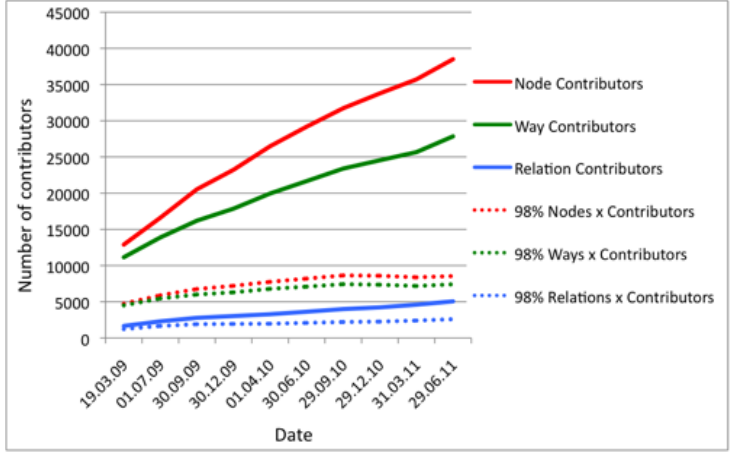
Figure 1. Number of OSM Contributors in Germany from 2009 to